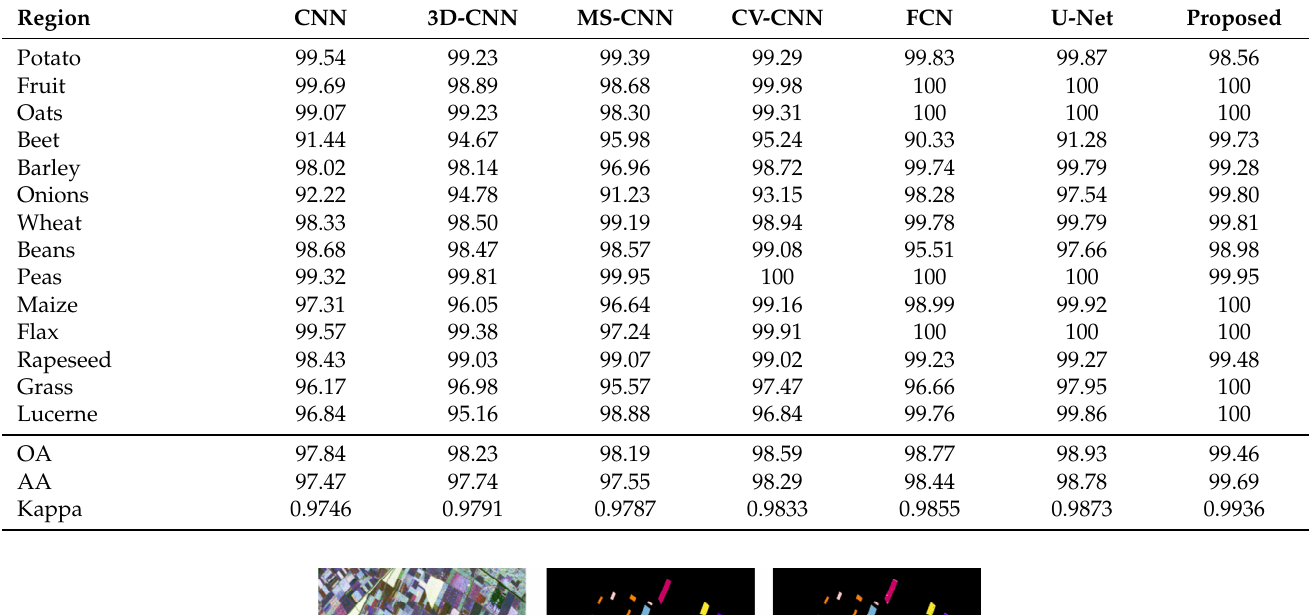
Table 7. Classification results of different methods in the Flevoland-14 dataset.